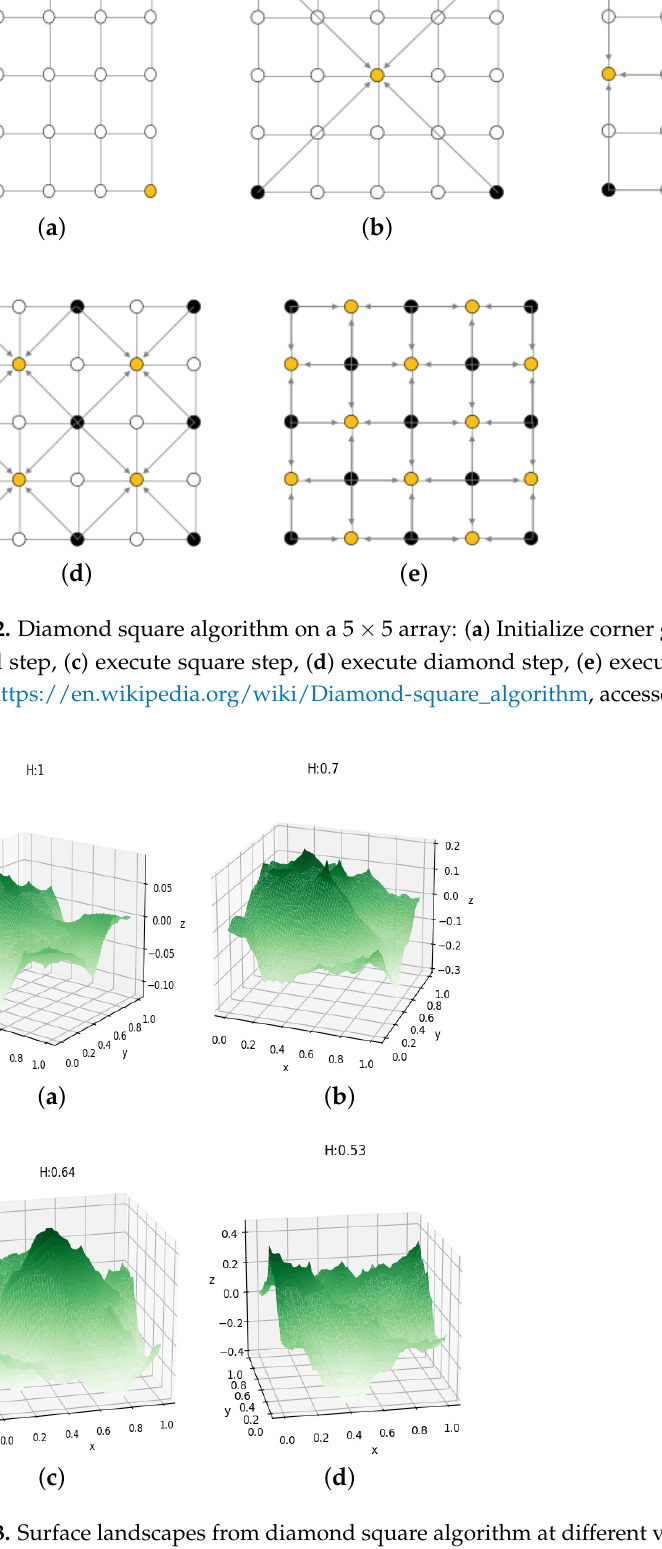
Figure 13. Surface landscapes from diamond square algorithm at different values of H : ( a ) H = 1.0, ( b ) H = 0.70, ( c ) H = 0.64, and ( d ) H =